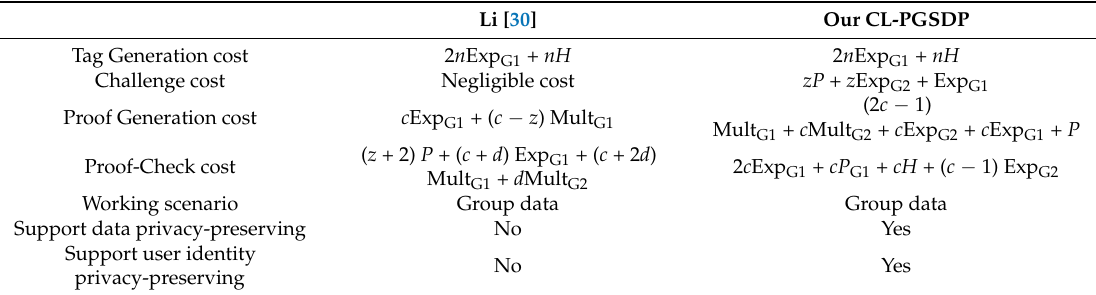
Table 1. Comparison with Li